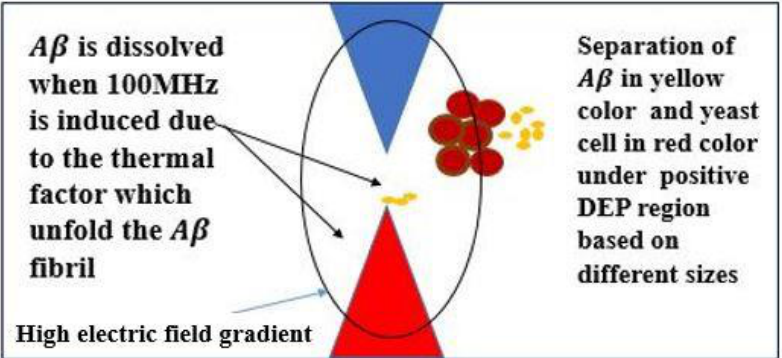
Figure 6. Schematic at 5Vpp 100MHz, at the tip of the electrode the temperature is increased at high frequency at high electric field 50kV/m. Its effects on the structure of Aβ is explained above. This indicates that at high frequencies, the high temperature has the ability to break down the A β . Hydrogen bonds are present in the structure of proteins. The purpose of hydrogen bonds